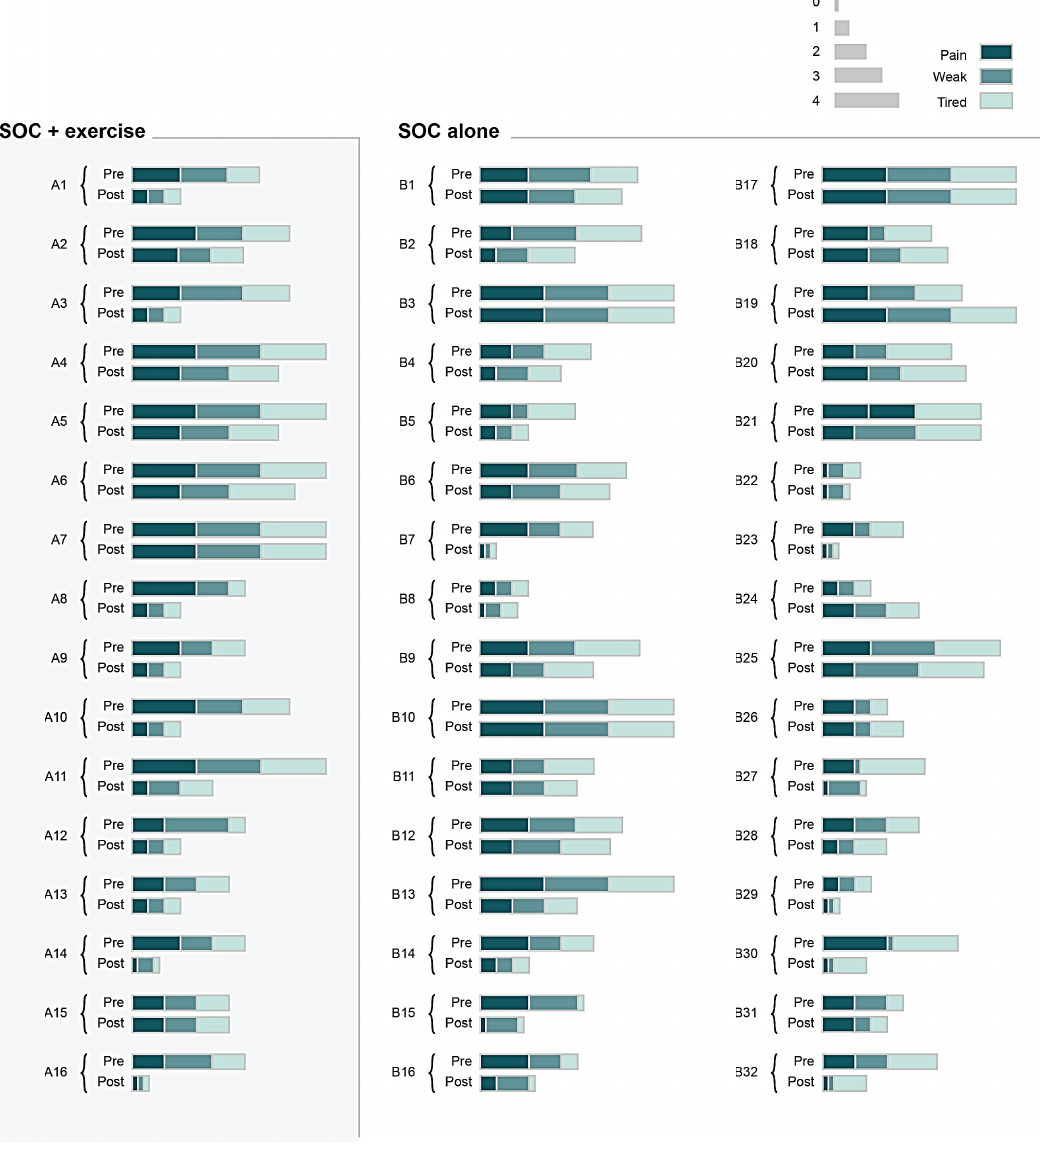
Figure 5. Heatmap illustrating patient-reported physical item scores at admission for individual study participants (within their respective group) before and after the single short bout. Different coloring indicates self-reported physical items: pain, weak, tired. The width of the color corresponds to the score of each parameter (0 = minimal, 4 = maximum). SOC, standard of care; SOC+Ex, standard of care plus